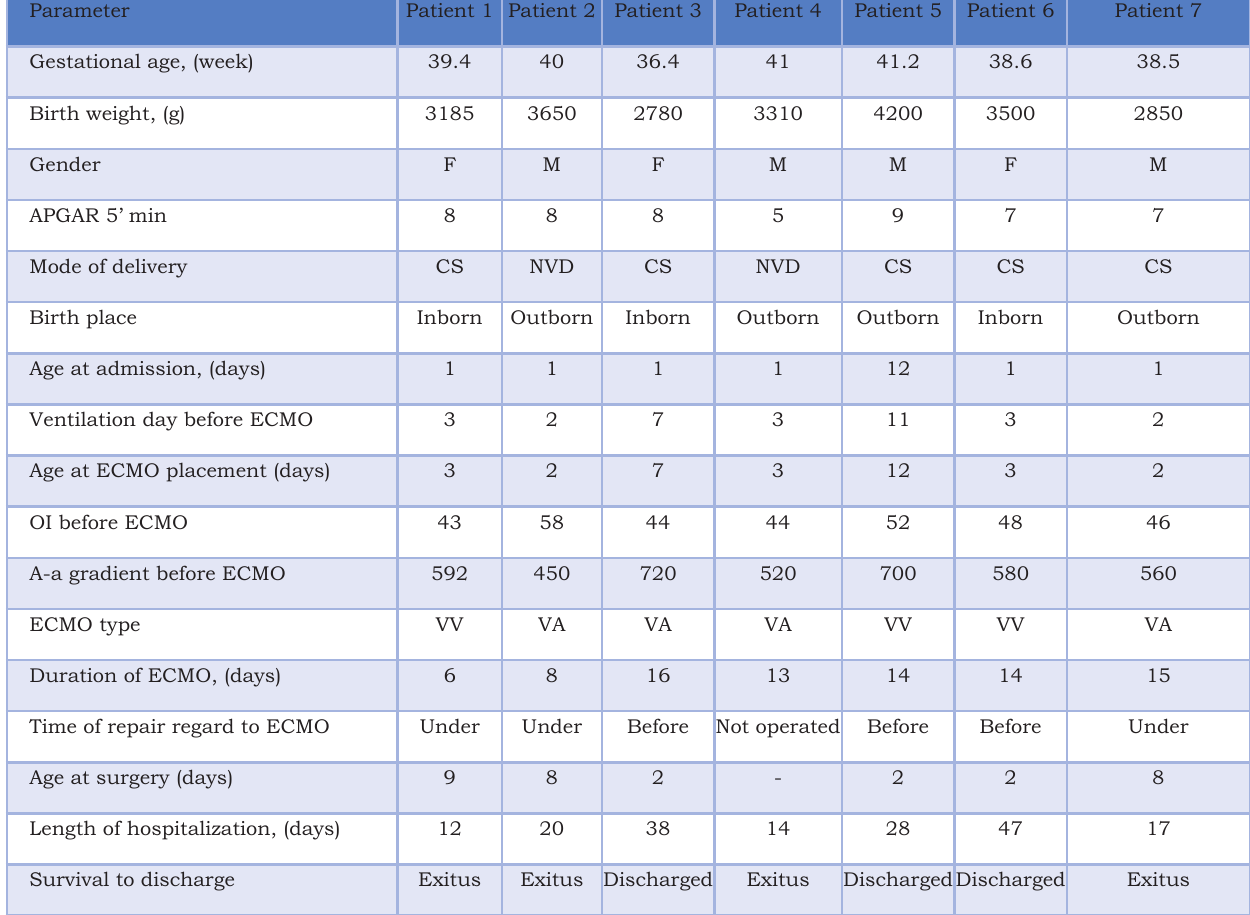
Table 2: The features of congenital diaphragmatic hernia patients treated with ECMO Parameter